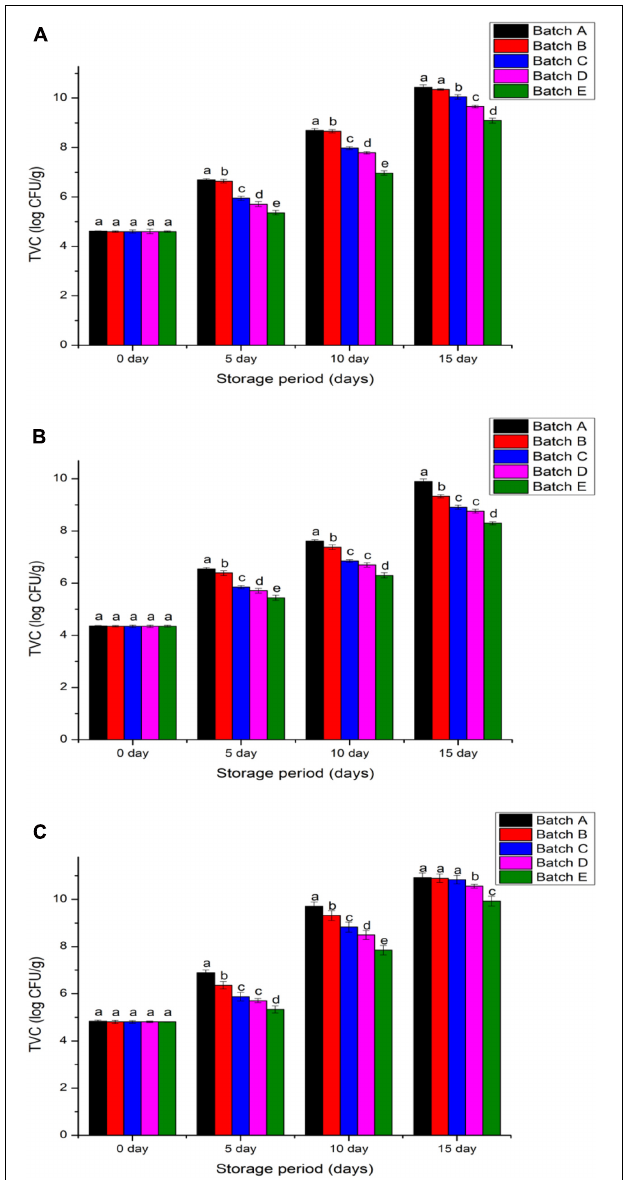
FIGURE 8 | Sensory scores of samples (A) Penaeus merguiensis , (B) Pampus argenteus , and (C) Tenualosa ilisha. Batch A: normal untreated, Batch B: treated with 2% glacial acetic acid, Batches C, D, and E were treated with different types of 2% chitosan solutions (0, 10, and 20 kGy). Value is provided as mean ± SE ( n = 3). The same letters (a–d) over the bar plot stands for insignificant difference ( p >